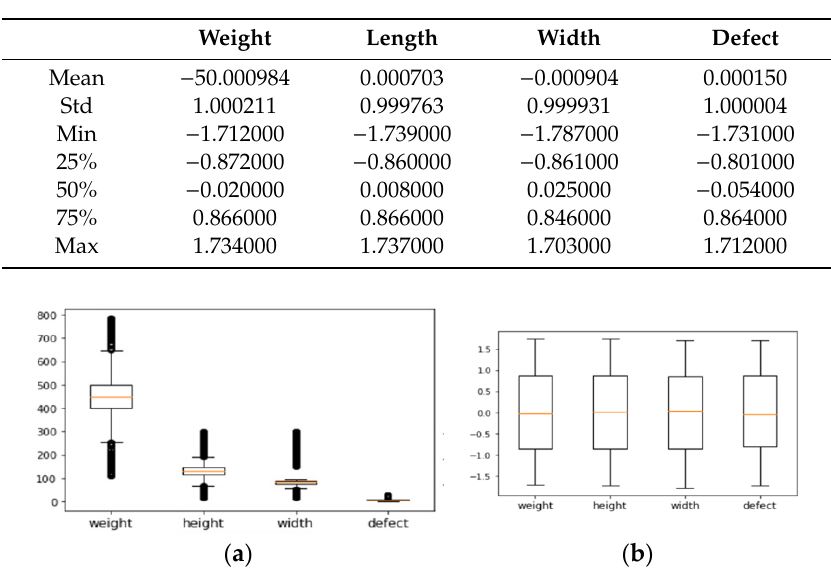
Table 4. Basic statistical information on the data using data normalization and elimination of outliers (DNEO).